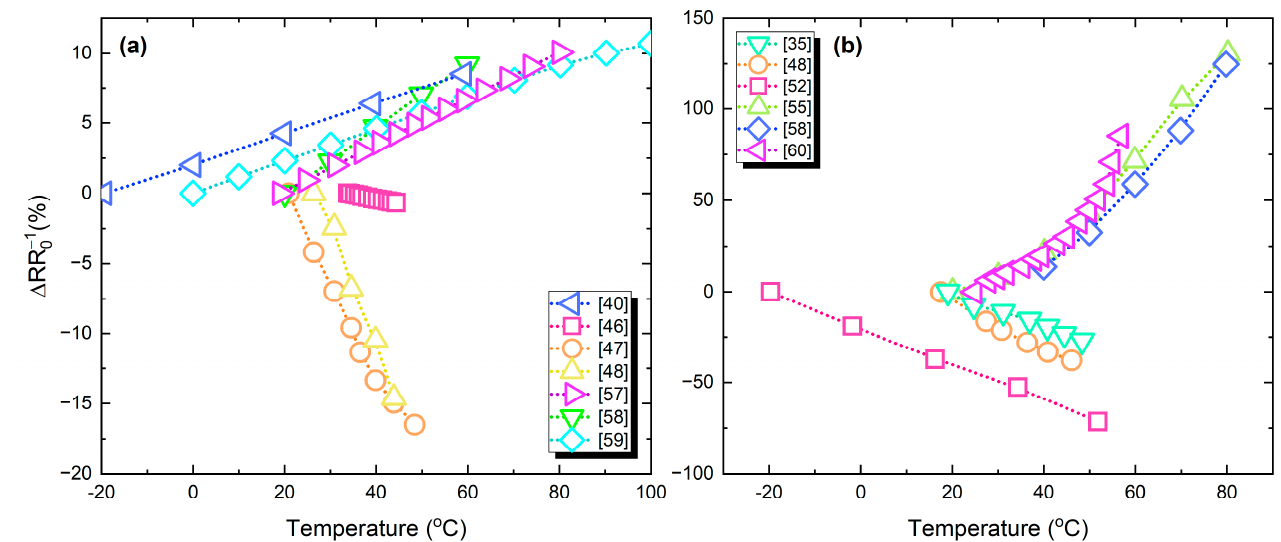
Figure 17. Temperature sensors relative resistance change to temperature variations: ( a ) devices with relatively lower response; ( b ) higher response.